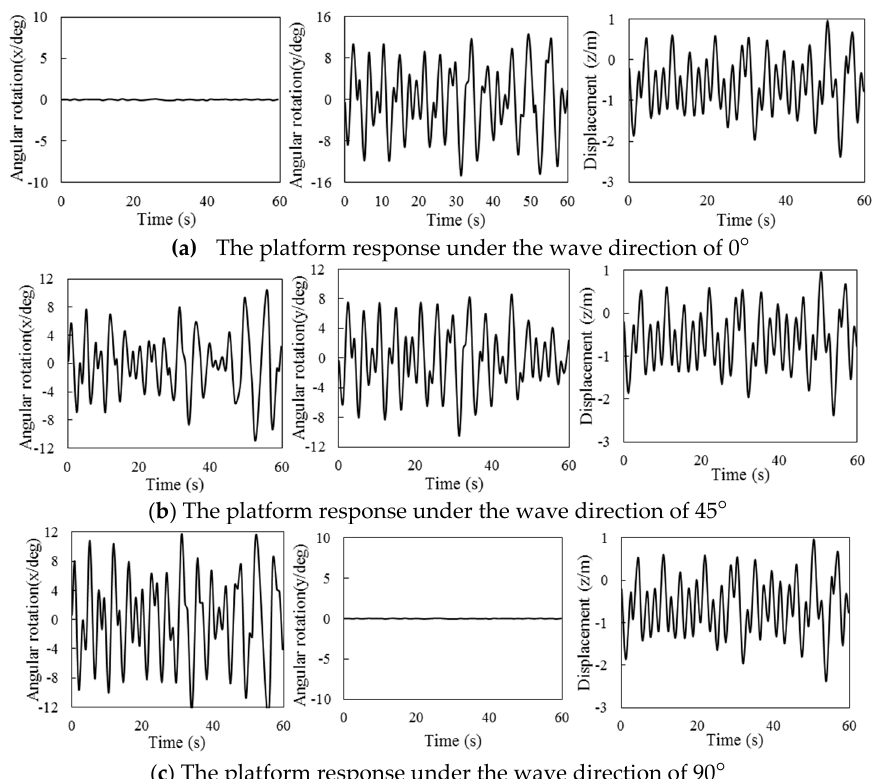
Figure 9. The platform response under wind − sea scale 4 with different wave directions.